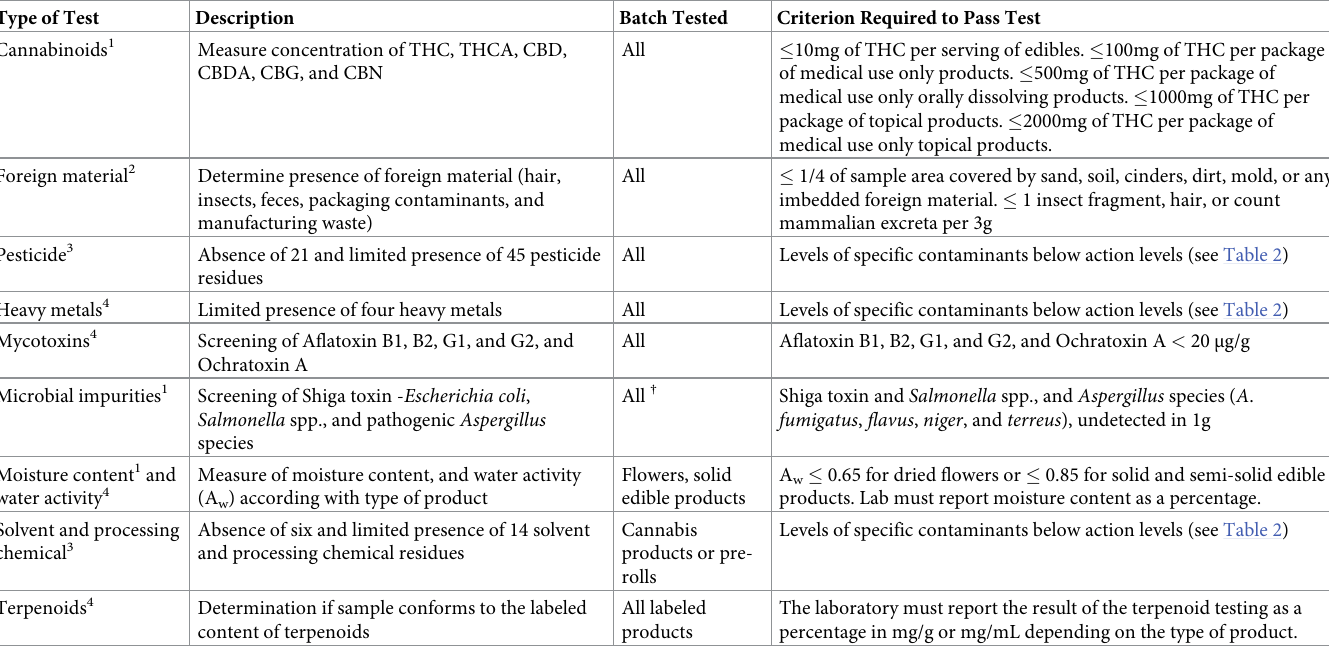
Table 1. Summary of mandatory testing per batch type and criterion used to pass